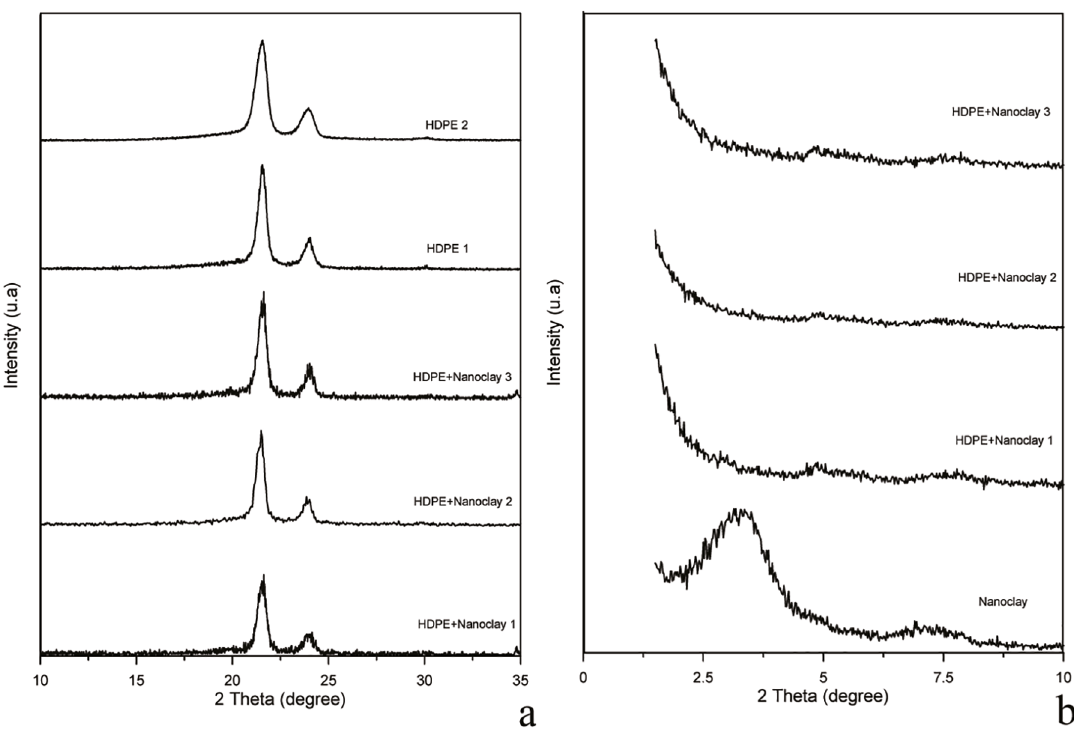
Figure 6. XRD patterns: a) High molecular weight polyethylene and nanocomposites. b) Low angle for the clay and nanocomposites.